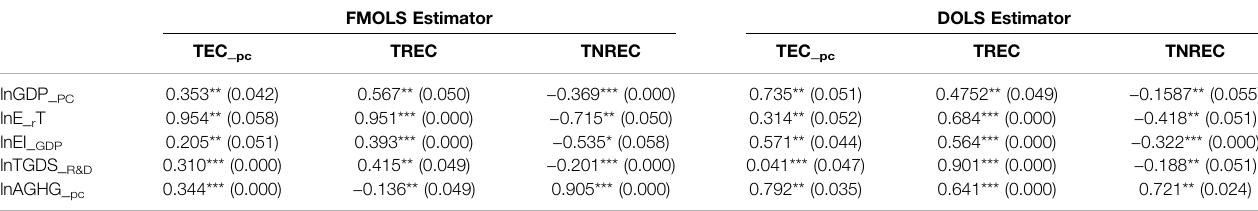
TABLE 8 | Results of robustness based on FMOLS and DOLS. FMOLS Estimator DOLS